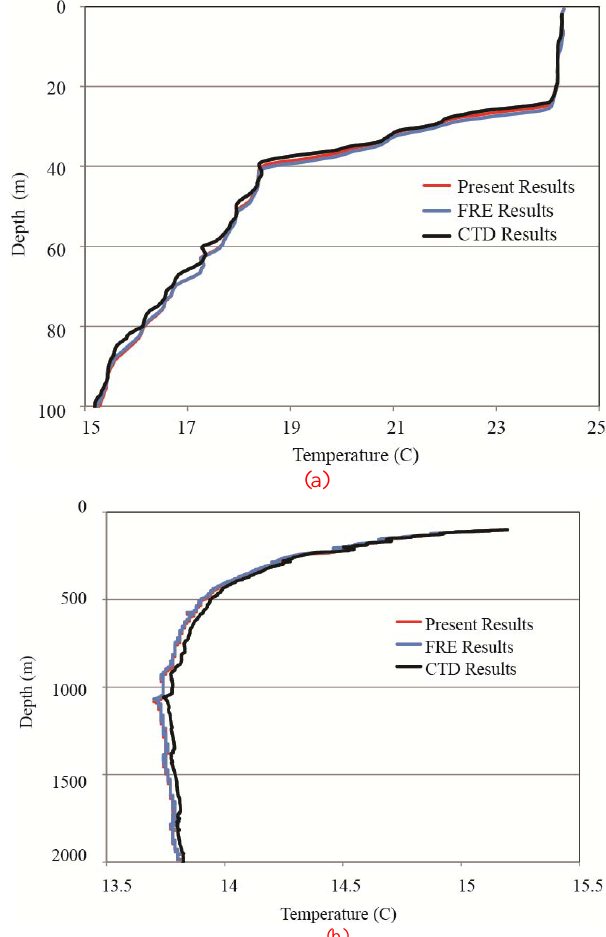
Fig. 9 a and b – Comparison of the present method with a collocated CTD experiment. Fig. 9. Comparison of the present method with a collocated CTD